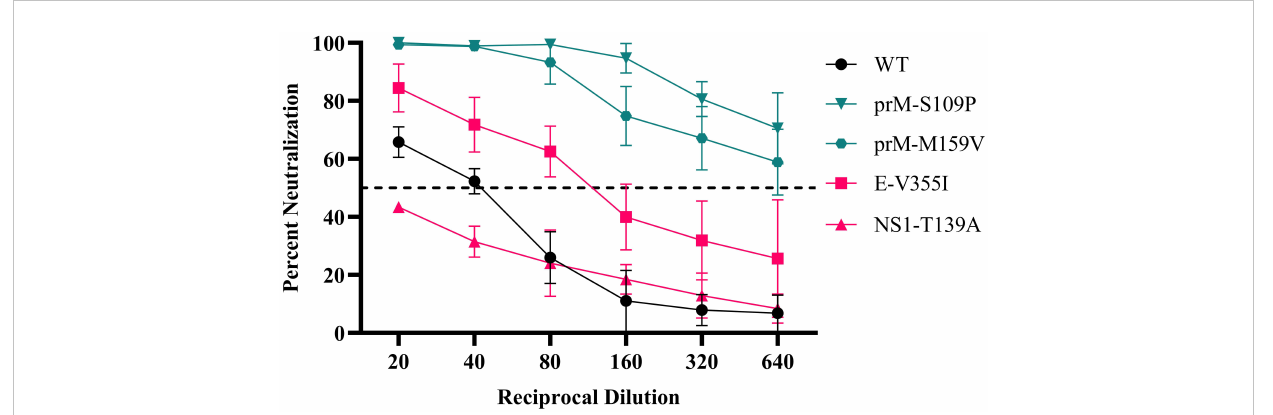
FIGURE 4 ZIKV mutant neutralization sensitivity. anti-DENV pool were serially diluted and mixed with WT ZIKV (black line), mutants from the anti-DENV pool population (red lines), or mutants identi fi ed from the Control Serum-passaged population (green lines). Data are from two biological replicates, each with three technical replicates, and the error bars represent the standard deviation from the mean. The dotted line represents the limit of